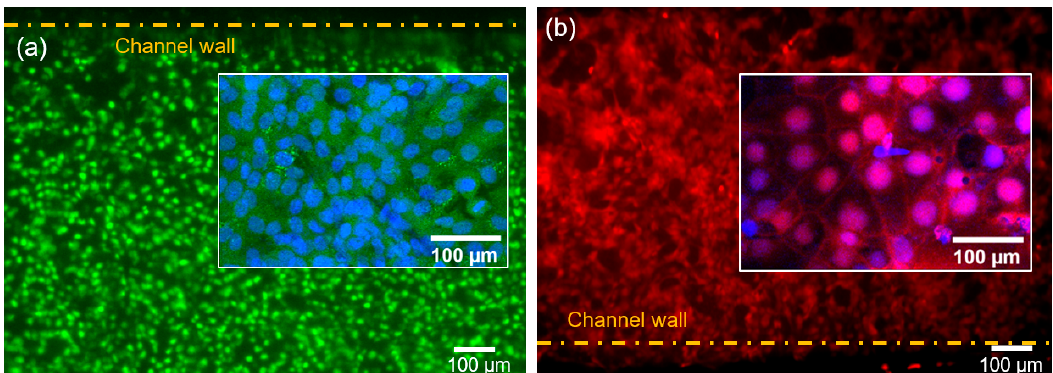
Figure 2. Cells in channels after 72 h of cell co-culturing. ( a ) Representative fluorescence image of human umbilical vein endothelial cells (HUVECs) stained with calcein-AM with the inset showing the nuclei stained with Hoechst 33342. ( b ) Representative fluorescence image of BeWo cells stained with CellTracker Orange Florescent Probe with the inset showing the nuclei stained with Hoechst 33342.